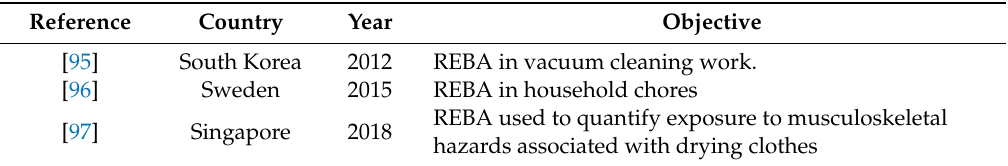
Table 9. Activities of households as employers; undi ff erentiated goods—and services—producing activities of households for own